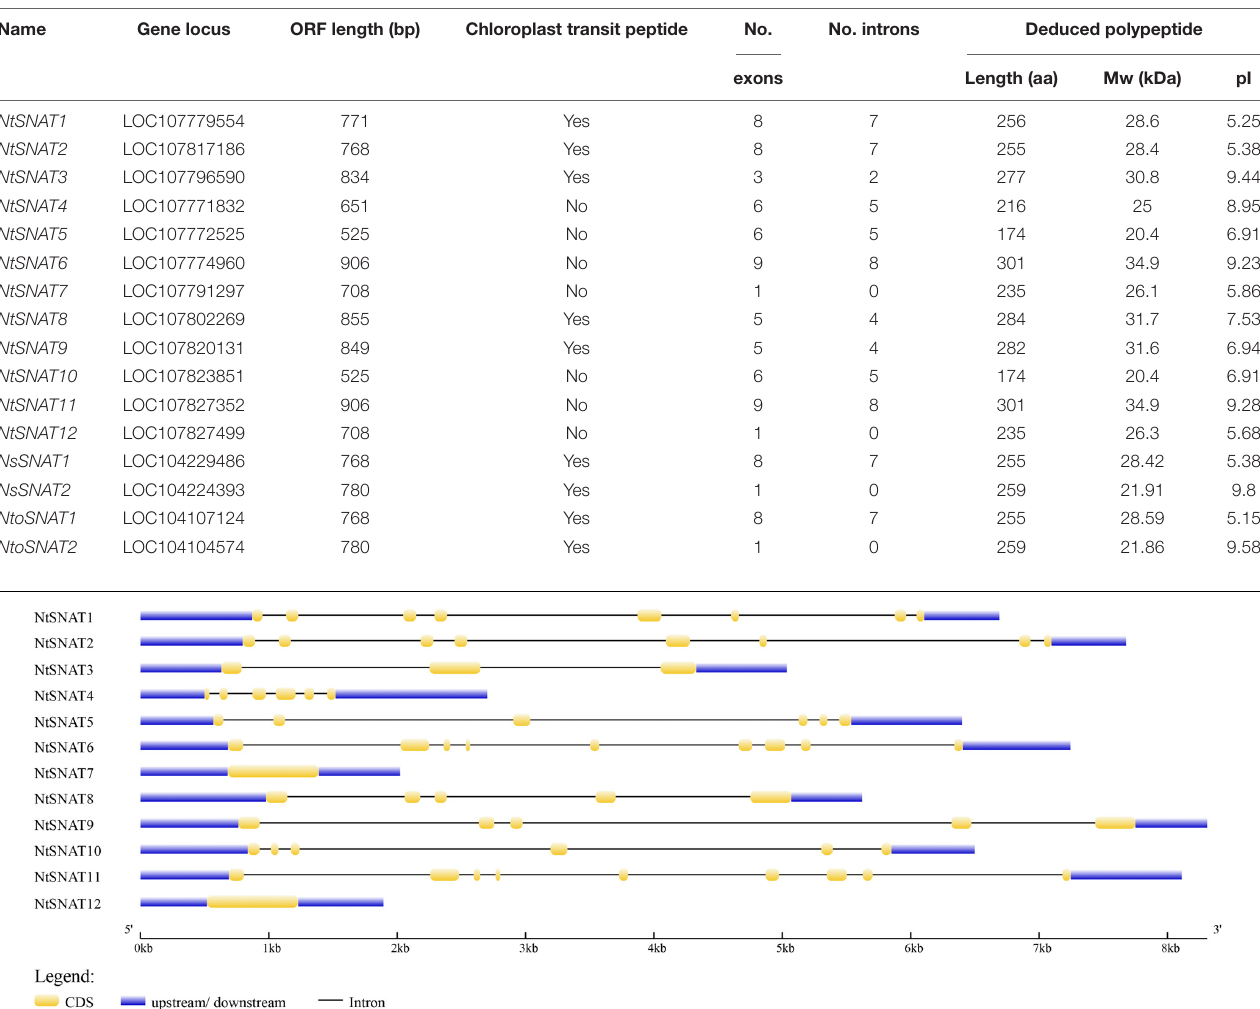
TABLE 1 | SNAT gene candidates in tobacco, Nicotiana tomentosiformis , and Nicotiana sylvestris.